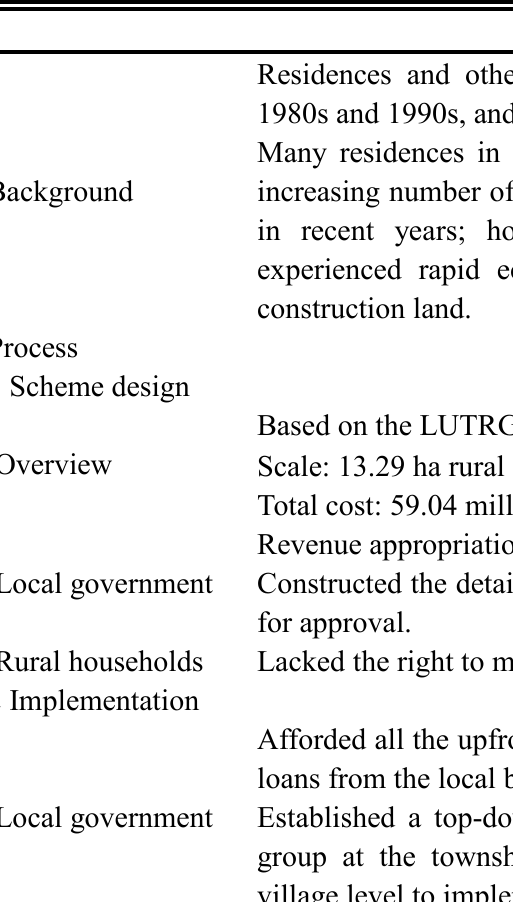
Table A3.1: Archetype 1 Government-led rural renewal with a short-term